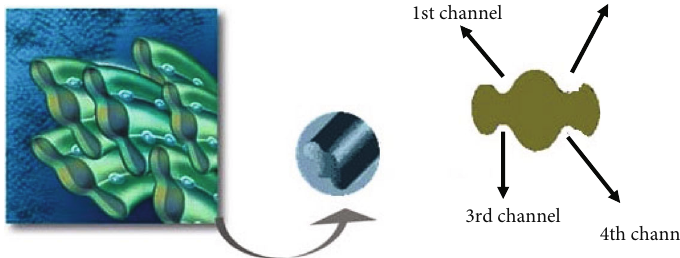
Figure 6: Moisture-wicking mechanism in Coolmax fi ber [50].